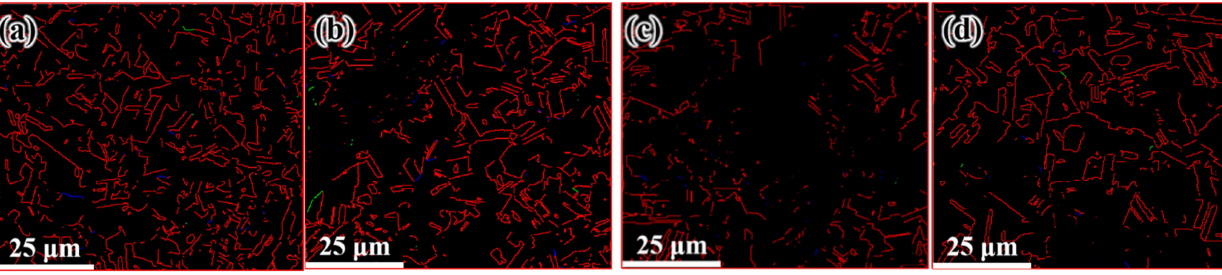
Figure 10. Distribution of twin boundary after FCE at 150 ◦ C: ( a ) 250 µ m from the edge, ( b ) 1 mm from the edge, ( c ) 2 mm from the edge, ( d ) 4 mm from the